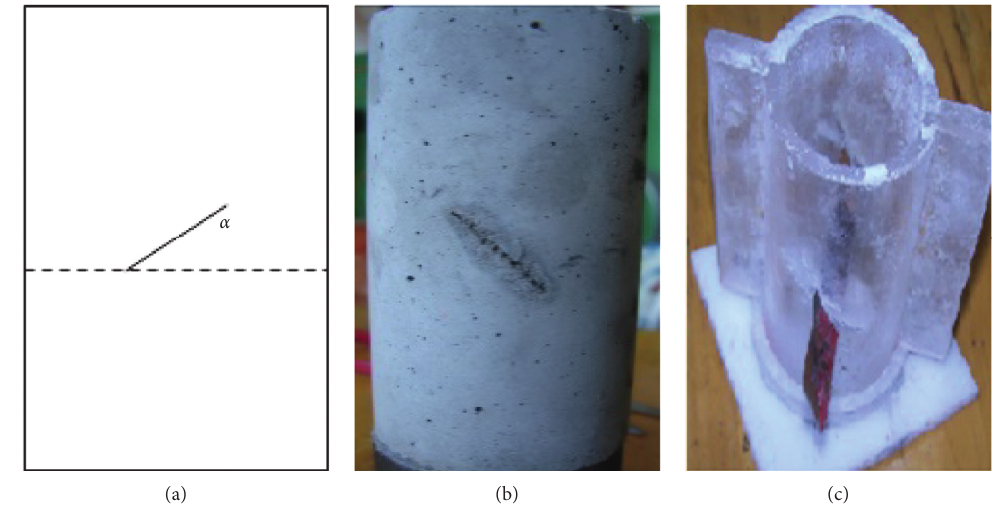
Figure 2: Sketch map of molding tool and cracked